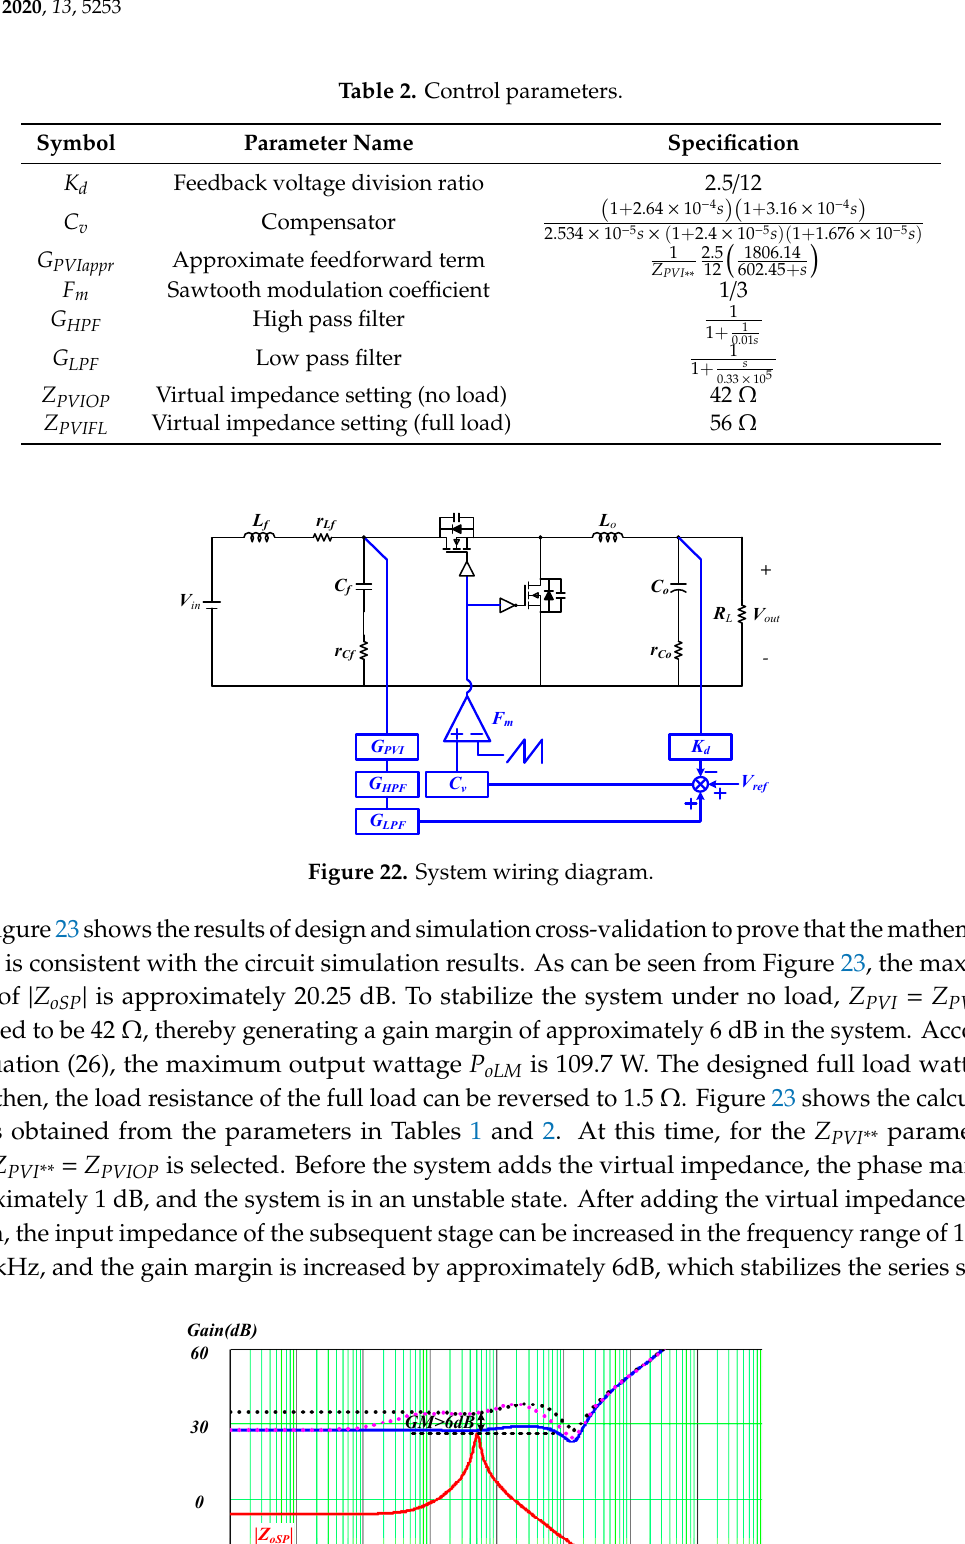
Table 2. Control parameters.